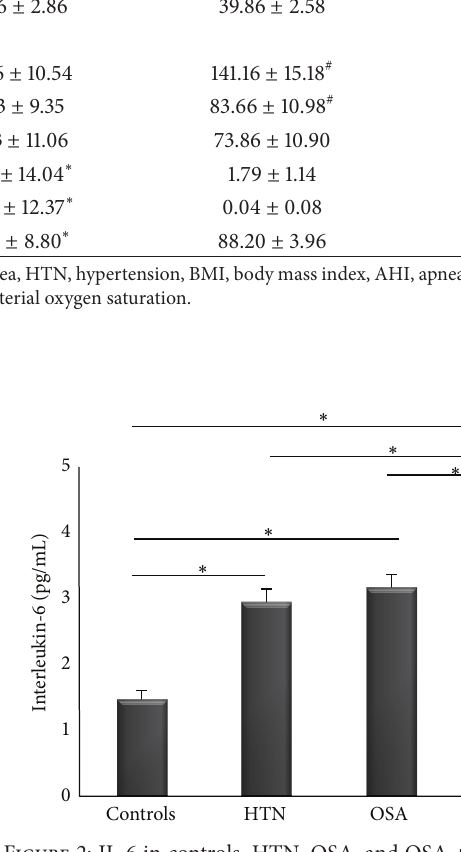
Figure 2: IL-6 in controls, HTN, OSA, and OSA + HTN subjects. ∗ 𝑝 < 0.01